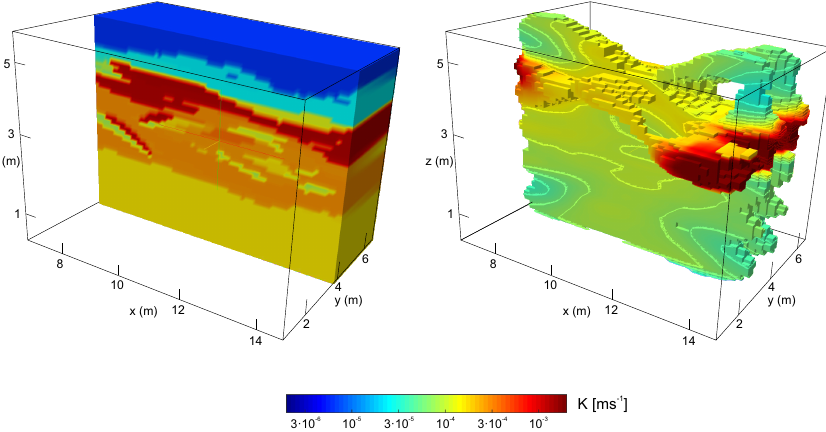
Figure 6. 3-D distribution of hydraulic conductivity ( K ): (a) investigated subdomain of the upscaled aquifer analog and (b) reconstructed tomogram with additional contour lines and unsliced high- K